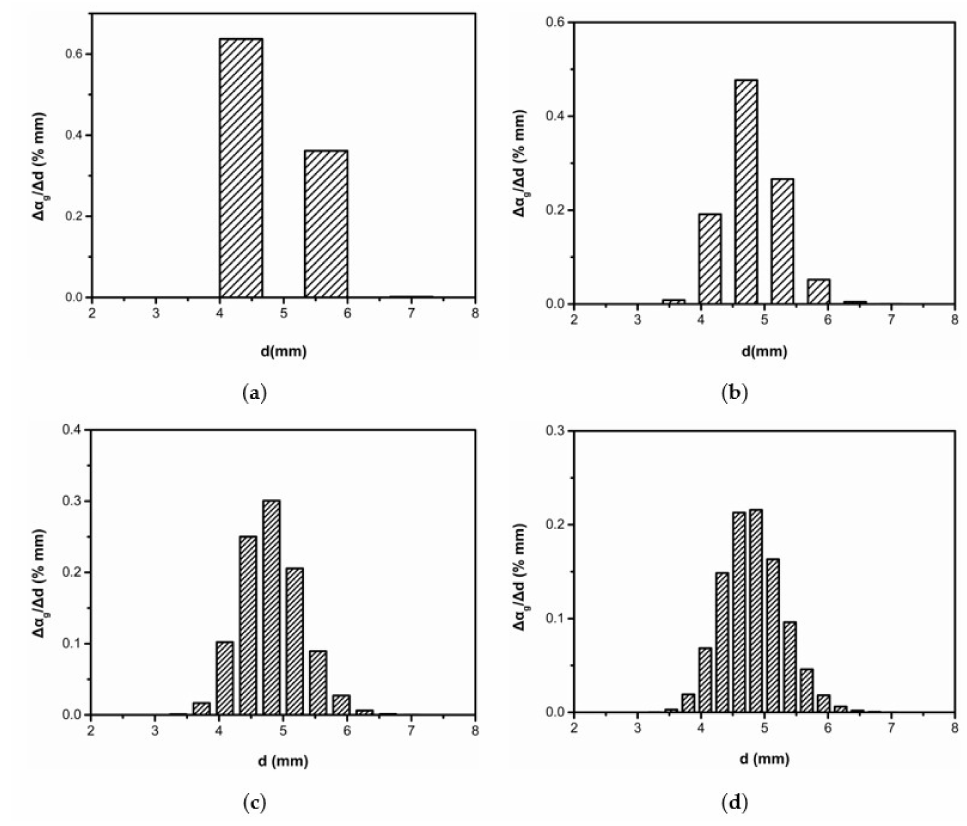
Figure 9. Bubble diameter distributions in different grouping schemes. ( a ) 4 airs (top left). ( b ) 8 airs (top right). ( c ) 12 airs (bottom left). ( d ) 16 airs (bottom right).